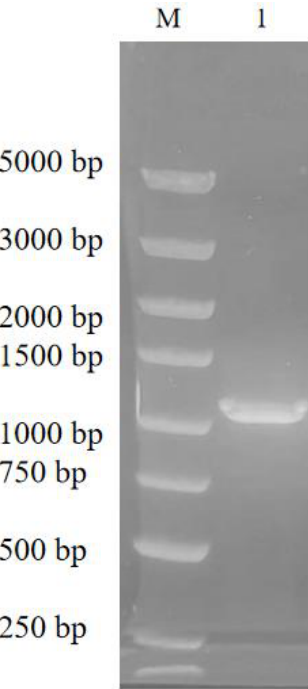
Figure 2. Agarose electrophoresis of the ATCC 7330 genome. Lane M: DNA marker. Lane 1: ATCC 7330 genome.